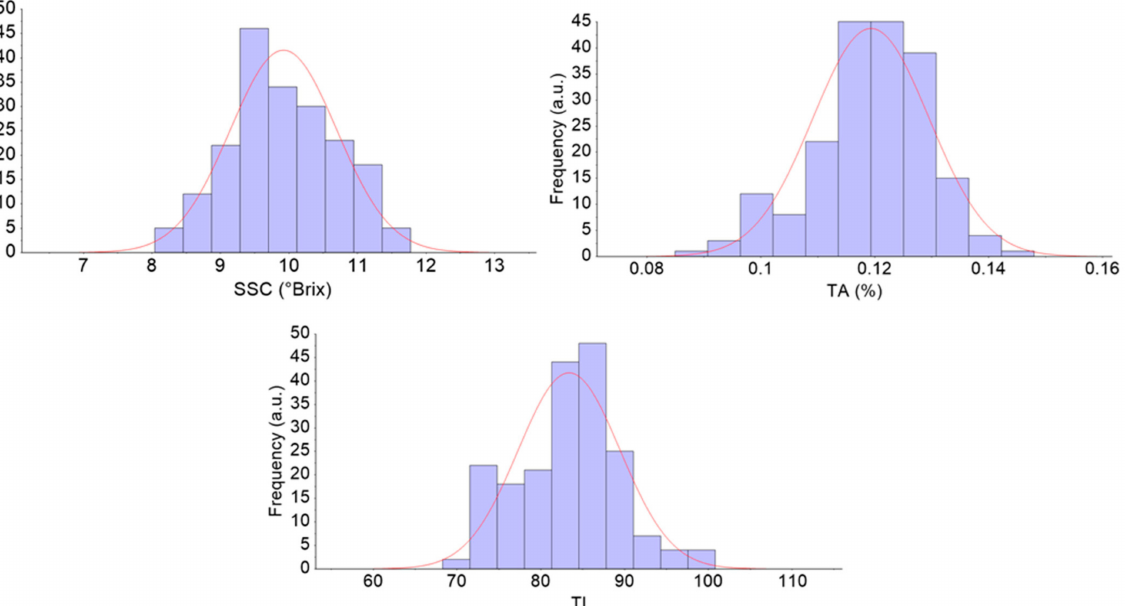
Figure 3. The SSC content distribution of all pears. a.u: arbitrary unit. SSC: soluble solid content; TA: titratable acidity; TI: taste